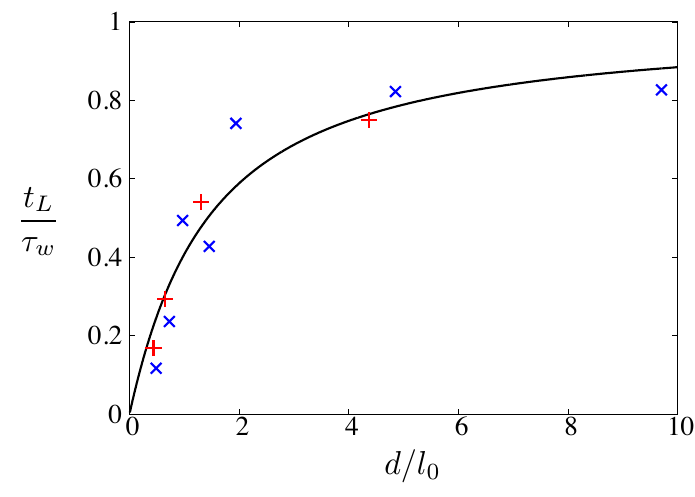
Figure 12: (from Ref. [ 31 ] ) Quasiparticle density decay rate s = 1 /τ ized by the inverse of the diffusion time t = π D / 2 Γ L ). The parameters t by l 0 qp eff dependence of the quasiparticle diffusion constant D The blue“x” (red “ + ”) symbols are for experiments performed at a fridge temperature of 13 mK (50 mK), at which the parameters t ≈ 46 µ m) where estimated. The solid line is obtained from a numerical solution ( l 0 of Eq. (116) when neglecting the second